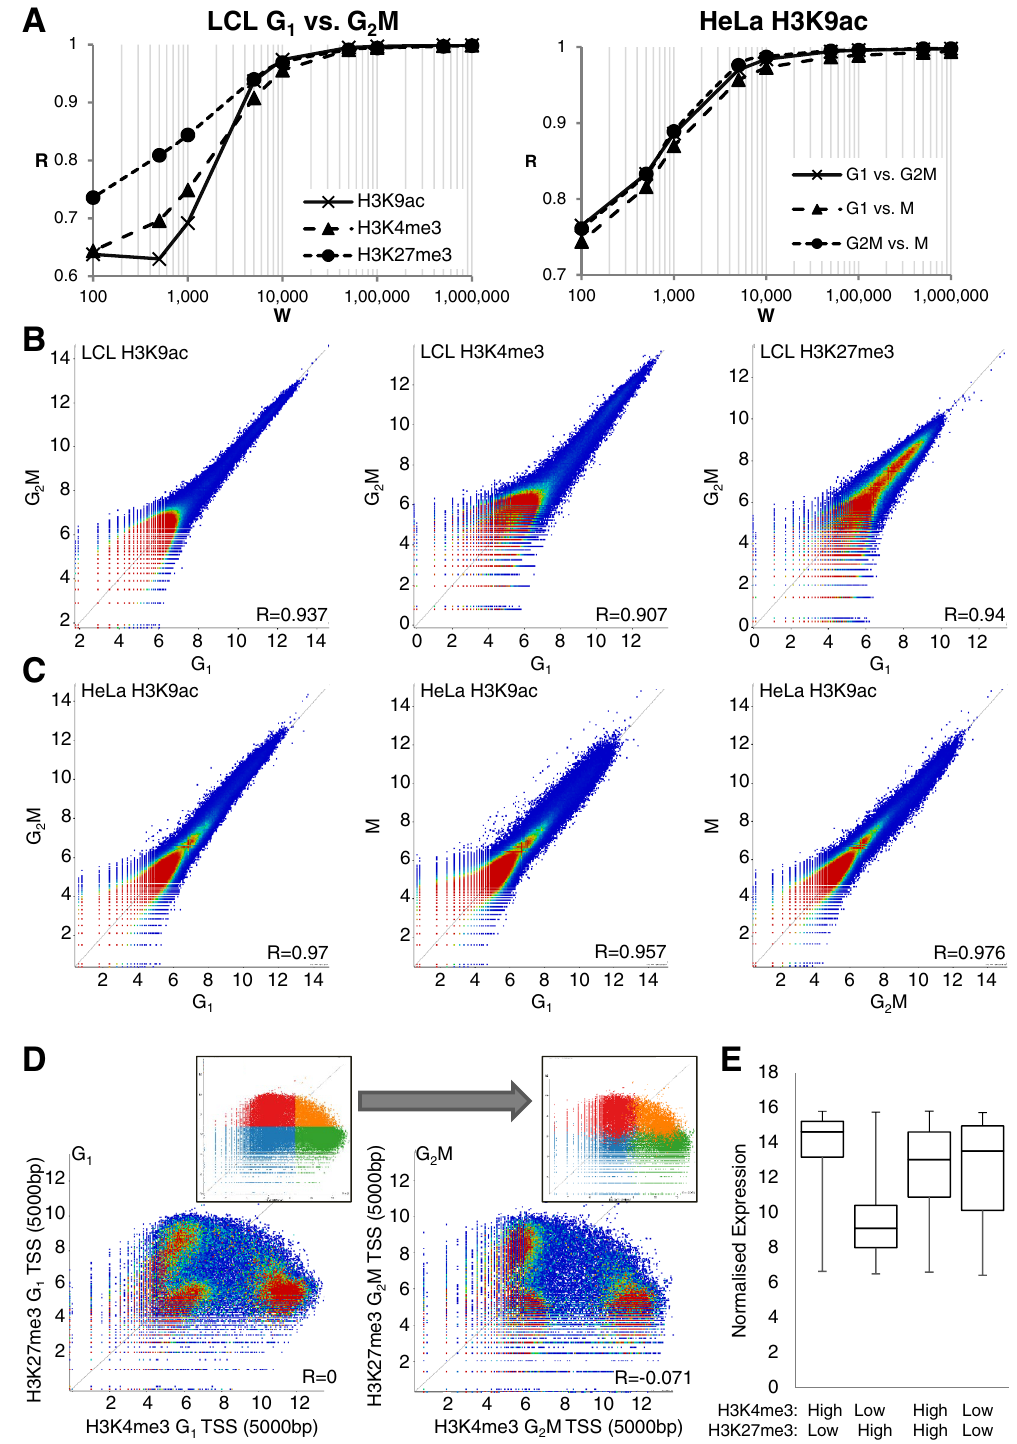
Figure 2. Rolling window analysis of histone modification patterns shows strong conservation through the cell cycle. ( A ) ChIP-seq of H3K9ac, H3K4me3 and H3K27me3 were compared in G 1 vs. G 2 M in LCL and H3K9ac in G 1 vs. G 2 M vs. M in HeLa cells using rolling windows of various sizes. Pearson correlation coefficient R is plotted against window size (W) for rolling windows of 100 bp–1 MB. ( B ) 5 kb windows were subsequently chosen as most informative and rolling window comparison of H3K9ac, H3K4me3 and H3K27me3 in G 1 vs. G 2 M by dotplot is shown in FACs-sorted LCL and ( C ) elutriation and mitotic shake-off sorted HeLa cells. Values represent log 2 read count normalised to total read count in a 5 kb rolling window analysis with a 5 kb step. Pearson R values for each correlation are indicated. ( D ) Using 5 kb windows centred on transcription start sites (TSS), H3K4me3 was plotted against H3K27me3 in LCL in G 1 and G 2 M. Insets show the division of the G 1 plot into quadrants and the subsequent position of these probes in the G 2 M plot. ( E ) Expression levels of genes from TSS in each quadrant was measured by microarray and summarised by boxplot showing median, interquartile range, minimum and